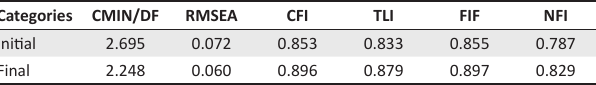
TABLE 4: Achieved fit indices. Categories CMIN/DF